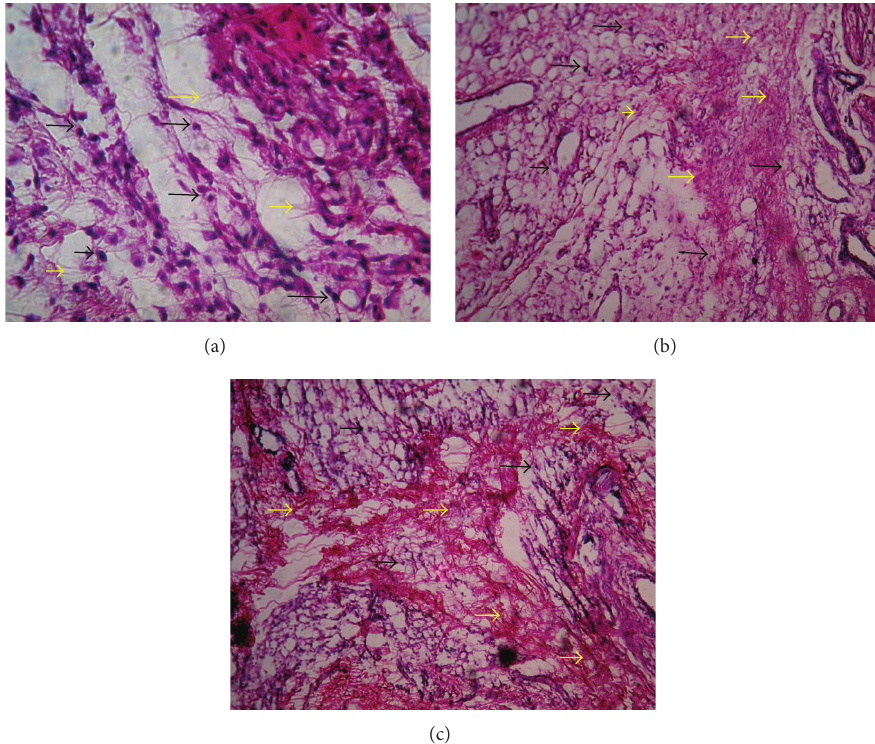
Figure 5: Histopathology of granulation tissue at day 10 stained with H&E (100x). (a) Granulation tissue of control rat showed mononuclear inflammatory cells (marked by black arrow), scattered abundance of eosinophilic fibroblasts (marked by yellow arrow). (b) AME treated showing large number of collagen tissue (fibrosis) and neovascularisation with minimal inflammatory cells. (c) VTE treated showing near to normal features, collagen tissue (fibrosis), and